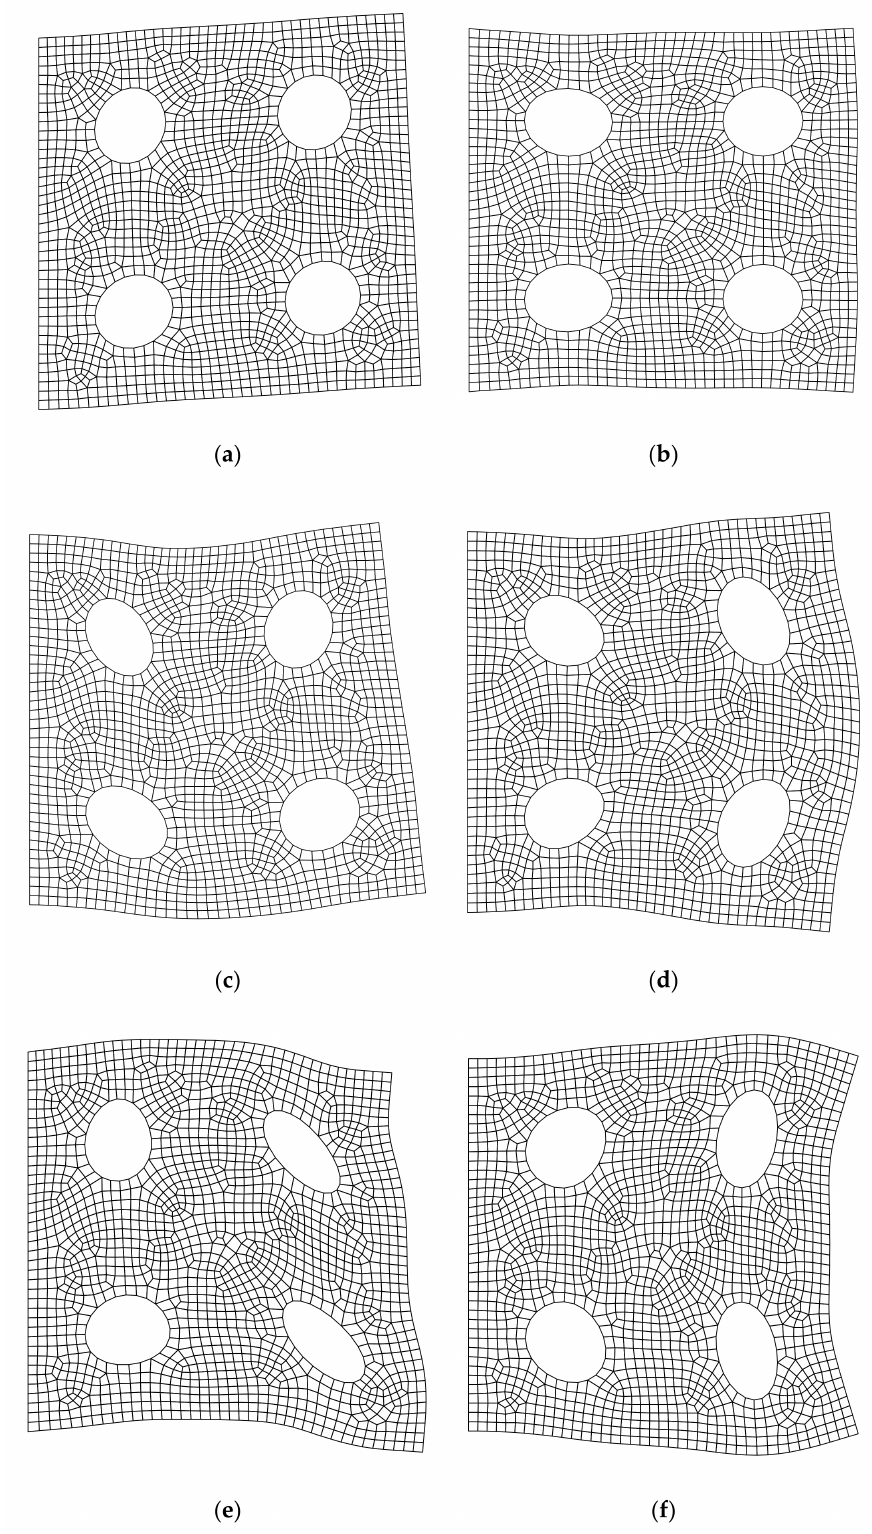
Figure 19. First 6 mode shapes of the plate with four holes using FE-RPIM QUAD4 element (CMM): ( a ) Mode 1; ( b ) Mode 2; ( c ) Mode 3; ( d ) Mode 4; ( e ) Mode 5; ( f ) Mode